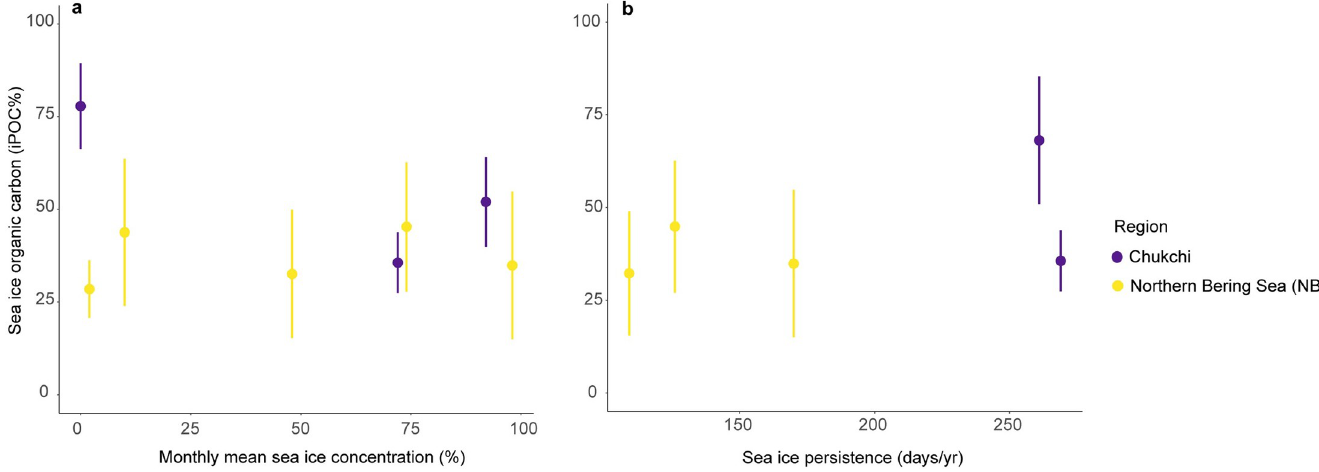
Fig 3. Sea ice indexes and sea ice organic carbon. (a) Monthly mean sea ice concentration (%) and mean sea ice organic carbon. Individual points represent the mean sea ice organic carbon with standard deviation. (b) Sea ice persistence (days/year) and sea ice organic carbon.